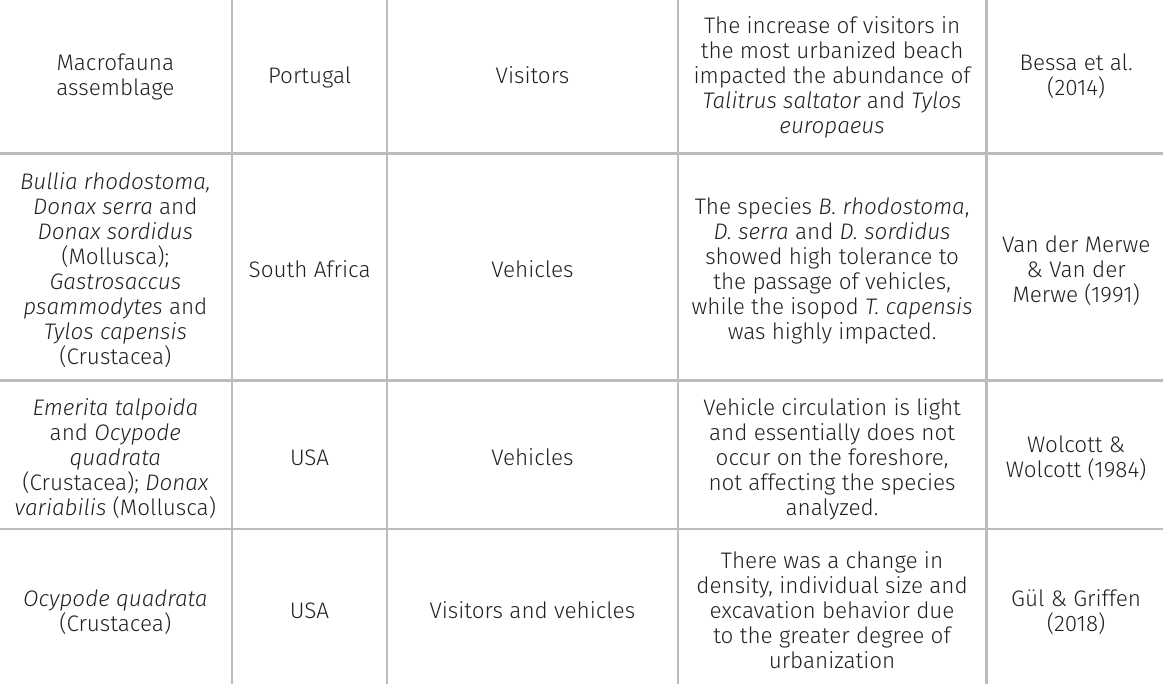
Bullia rhodostoma, Donax serra and Donax sordidus (Mollusca); Gastrosaccus psammodytes and